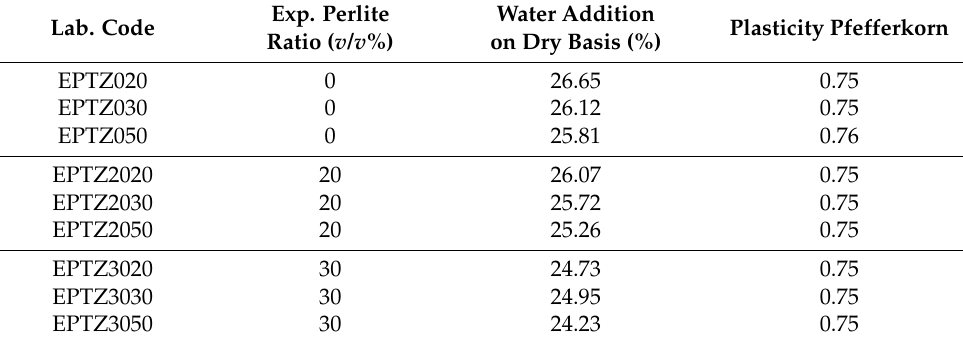
Table 5. Mixture proportions of clay brick